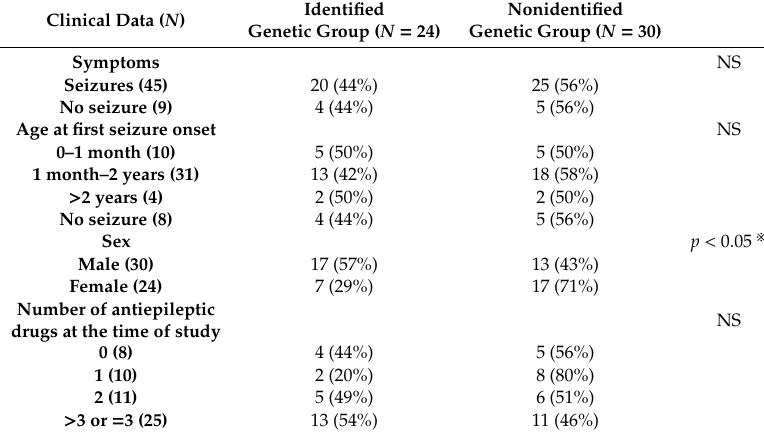
Table 1. The demographic data in identified genetic group and nonidentified genetic group by whole-exome sequencing (WES) are demonstrated. Identified Clinical Data ( N ) Genetic Group ( N =